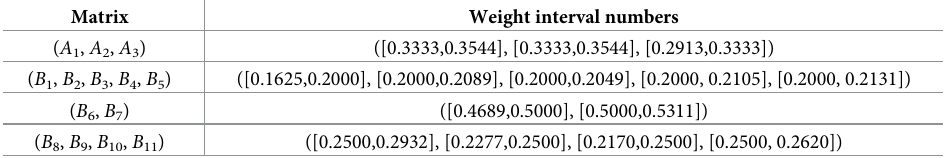
Table 12. Weight interval number of performance evaluation indices calculated in reference [49].